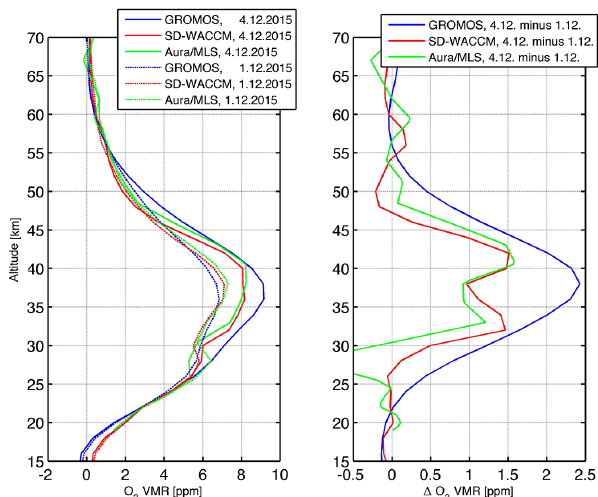
Figure 1. Time series of ozone volume mixing ratio and zonal wind at 34km altitude above Bern, Switzerland from October to Decem- ber 2015. The vertical red line is at 4 December 2015 12:00 UT when the ozone streamer reached Bern. (a) Time series of ozone observed by GROMOS (Bern) and SOMORA (Payerne) versus the simulated SD-WACCM ozone series at the grid point nearest to Bern. (b) Time series of eastward wind simulated by SD-WACCM at 34km altitude.